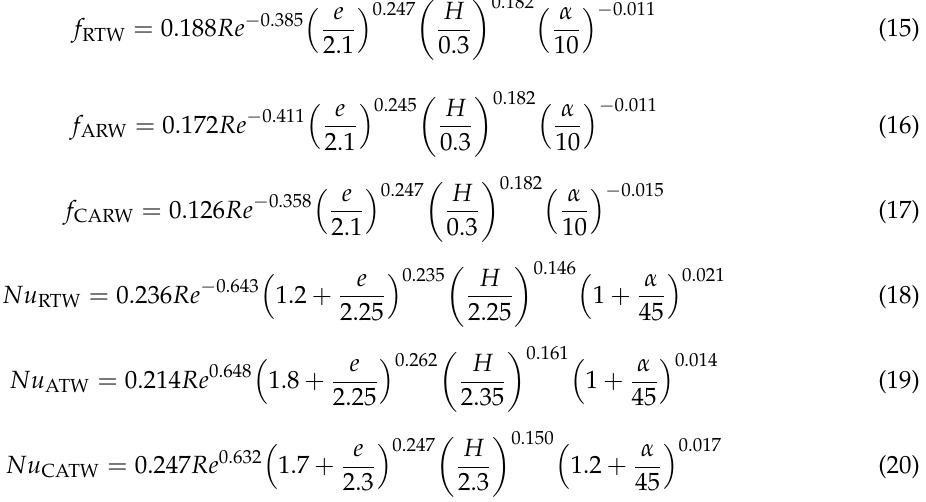
Figure 18. Proposed correlations to estimate the values of the average Nu number, friction factor f and synergy angle θ based on the Re number, attack angle α , tube ellipticity ratio e and wavy fin height H were obtained as